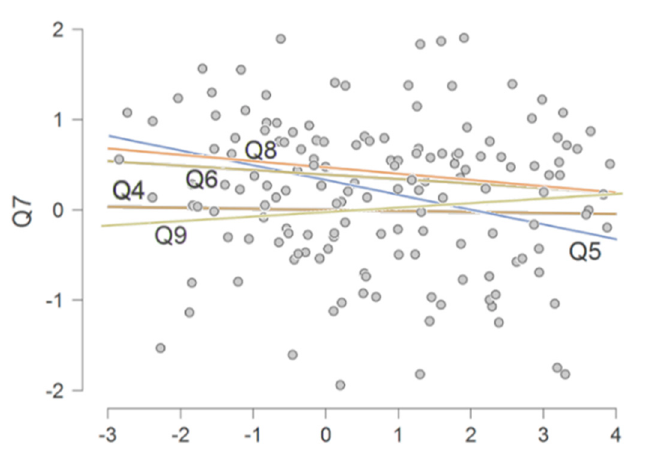
Figure 2. Multiple regression scatterplot, estimating the individual contribution of each predictive variable (Q4, Q5, Q6, Q8, and Q9) in changing the variance of the criterion value (Q7: “To what extent did you feel frustrated in relation to your work?”), to estimate the individual contribution of each answer by physical therapists to the other specific questions on psychological distress and work environmental factors.